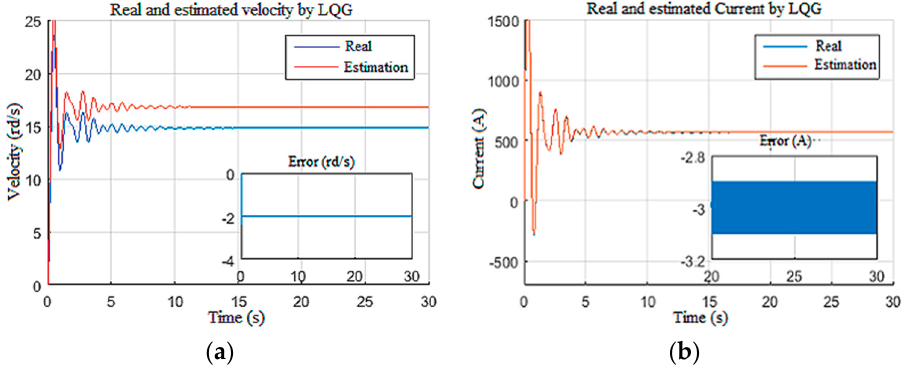
Figure 19. Top drive responses for Scenario 3: ( a ) velocity; ( b ) current.